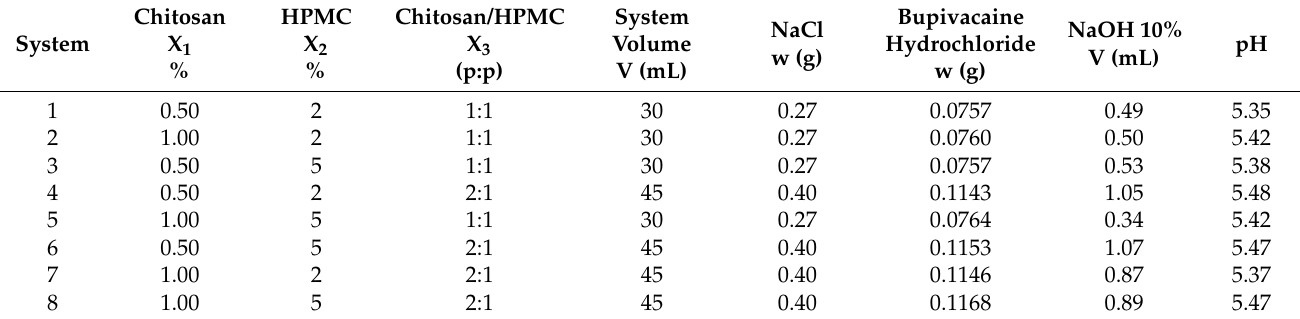
Table 1. Experimental matrix for chitosan- and HPMC E5 LV-based in situ gelling systems with bupivacaine hydrochloride.